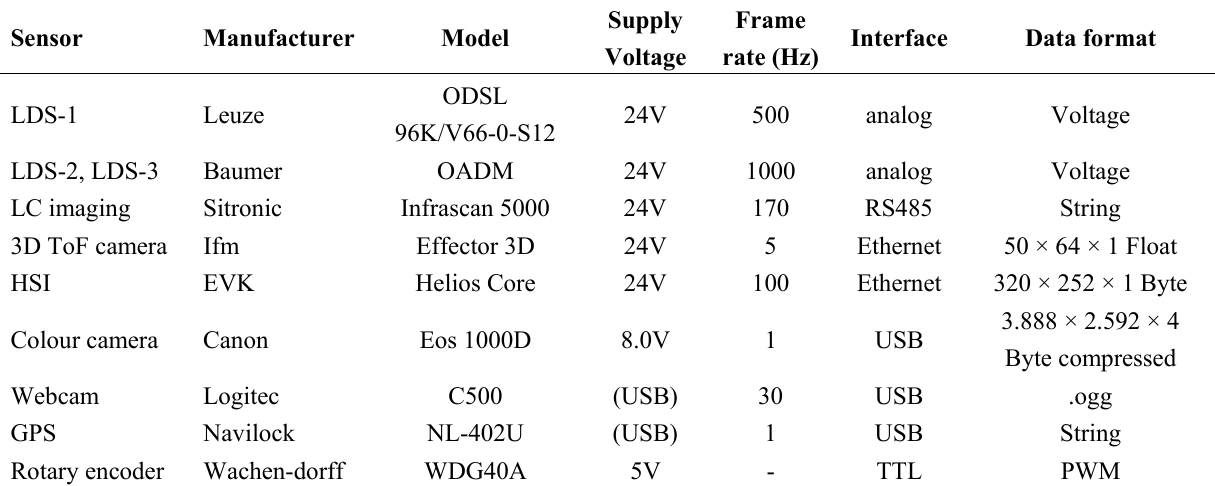
Table 1. Detailed technical information of the different types of integrated sensor systems for the phenotyping platform (LDS: laser distance sensor; LC: light curtain; ToF: Time-of-Flight; HIS: hyperspectral